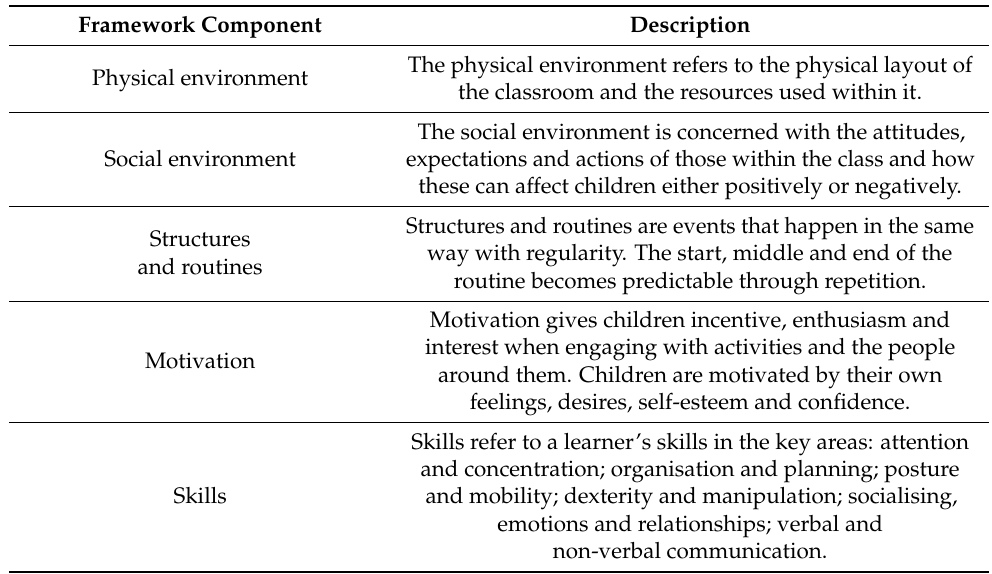
Table 1. Overview of CIRCLE framework components